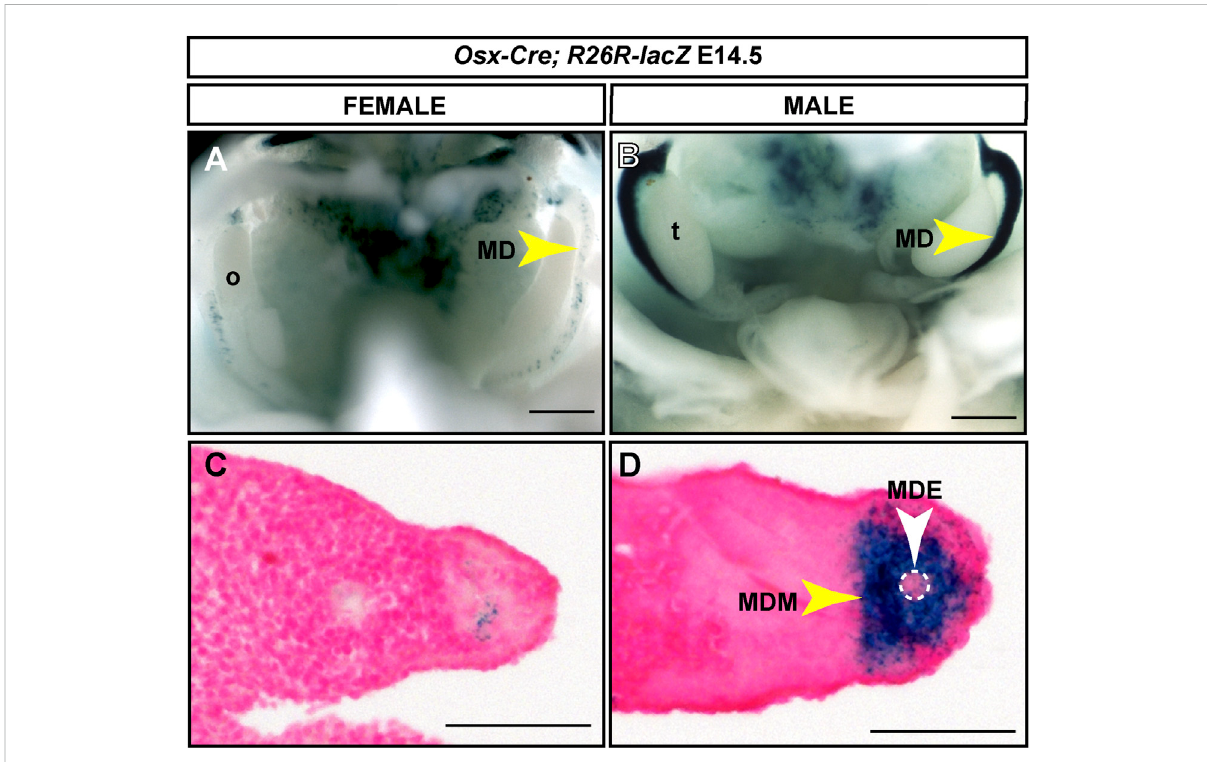
FIGURE 3 Male-speci fi c Müllerian duct mesenchyme expression induced by an Osx-Cre transgene. E14.5 reproductive tract organs from Osx-Cre tg/0 ; R26R-lacZ /+mouseembryosstainedfor lacZ expression. (AandB) Wholemountimagesforfemale (A) andmale (B) embryos.Scalebar=500um. (C and D) Cross sections through Müllerian ducts counterstained with Nuclear Fast Red. Scale bar = 50 um. t, testis; o, ovary; MD, Müllerian duct; MDE, Müllerian duct epithelium; MDM, Müllerian duct mesenchyme. Osx-Cre tg/0 ; R26R-lacZ /+ male embryos, n =